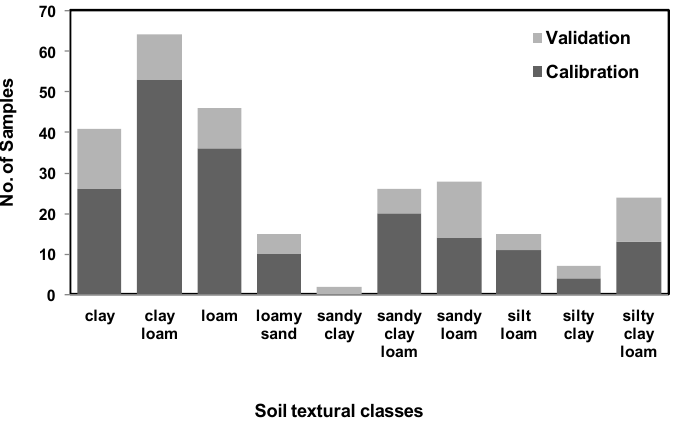
Figure 5. Chart (stacked histogram with two categorical variables (calibration data and validation data)) illustrating the distribution of textural soil class based on USDA [44,52].